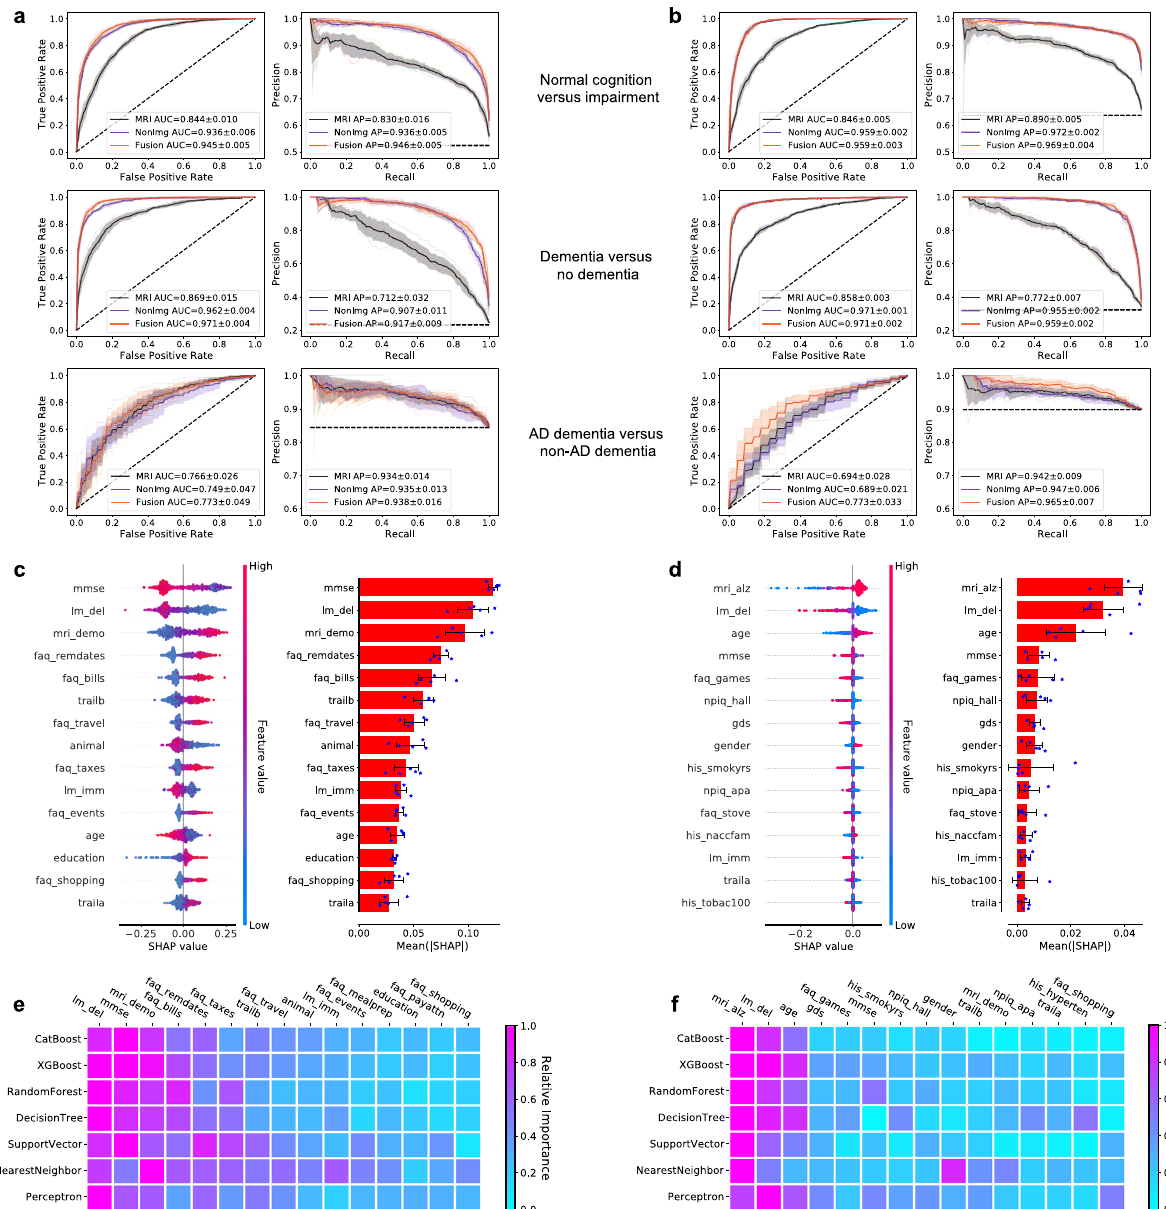
Fig. 3 Performance of the deep learning models. a , b ROC curves showing true positive rate versus false positive rate and PR curves showing the positive predictive value versus sensitivity on the a NACC test set and b OASIS dataset. The fi rst row in a and b denotes the performance of the MRI-only model, the non-imaging model, and the fusion model (CNN + CatBoost) trained to classify cases with NC from those without NC (COG NC task). The second row shows ROC and PR curves of the MRI-only model, the non-imaging model, and the fusion model for the COG DE task aimed at distinguishing cases with DE from those who do not have DE. The third row illustrates performance of the MRI-only model, the non-imaging model, and the fusion model focused on discriminating AD from nADD. For each curve, mean AUC was computed. In each plot, the mean ROC/PR curve and standard deviation are shown as bolded lines and shaded regions, respectively. The dotted lines in each plot indicate the classi fi er with the random performance level. c , d Fifteen features with highest mean absolute SHAP values from the fusion model are shown for the COG and ADD tasks, respectively across cross-validation rounds ( n = 5). Error bars overlaid on bar plots are centered at the mean of the data and extend + / − one standard deviation. For each task, the MRI scans, demographic information, medical history, functional assessments, and neuropsychological test results were used as inputs to the deep learning model. The left plots in c and d illustrate the distribution of SHAP values and the right plots show the mean absolute SHAP values. All the plots in c and d are organized in decreasing order of mean absolute SHAP values. e , f For comparison, we also constructed traditional machine learning models to predict cognitive status and AD status using the same set of features used for the deep learning model, and the results are presented in e and f , respectively. The heat maps show fi fteen features with the highest mean absolute SHAP values obtained for each model. Source data are provided as a Source Data fi